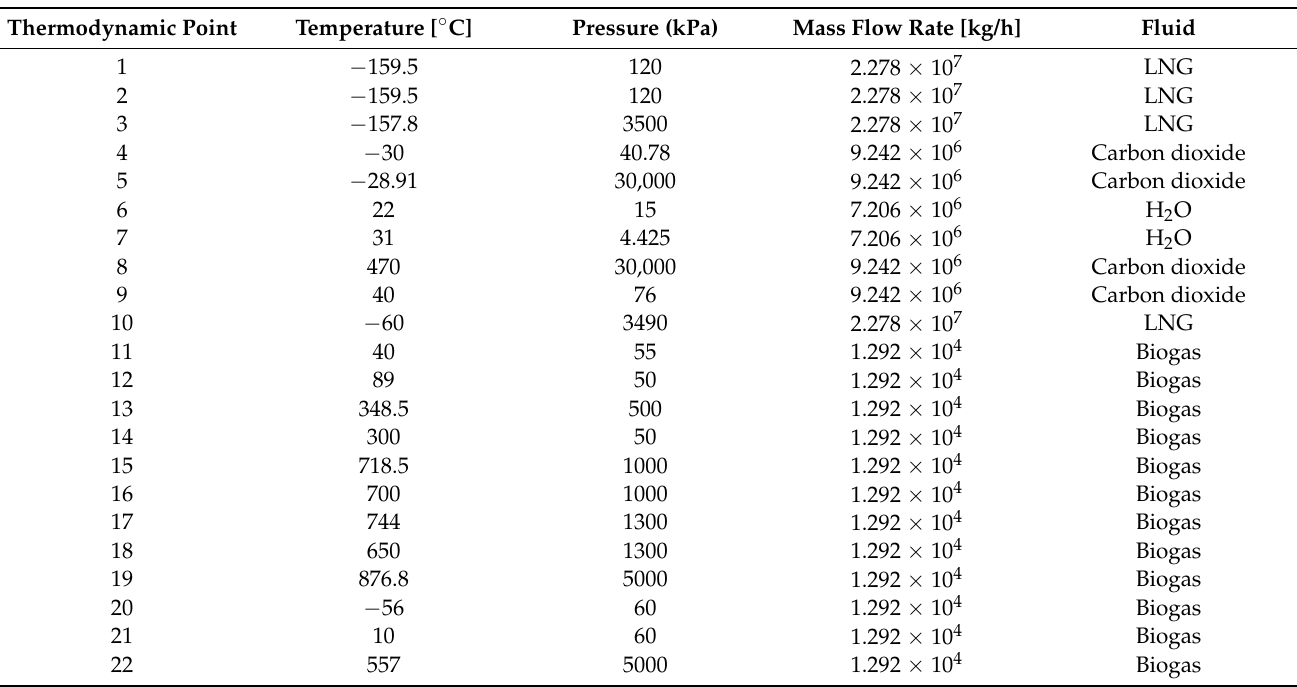
Table 5. Detail of Configuration II operating values using carbon dioxide as the working